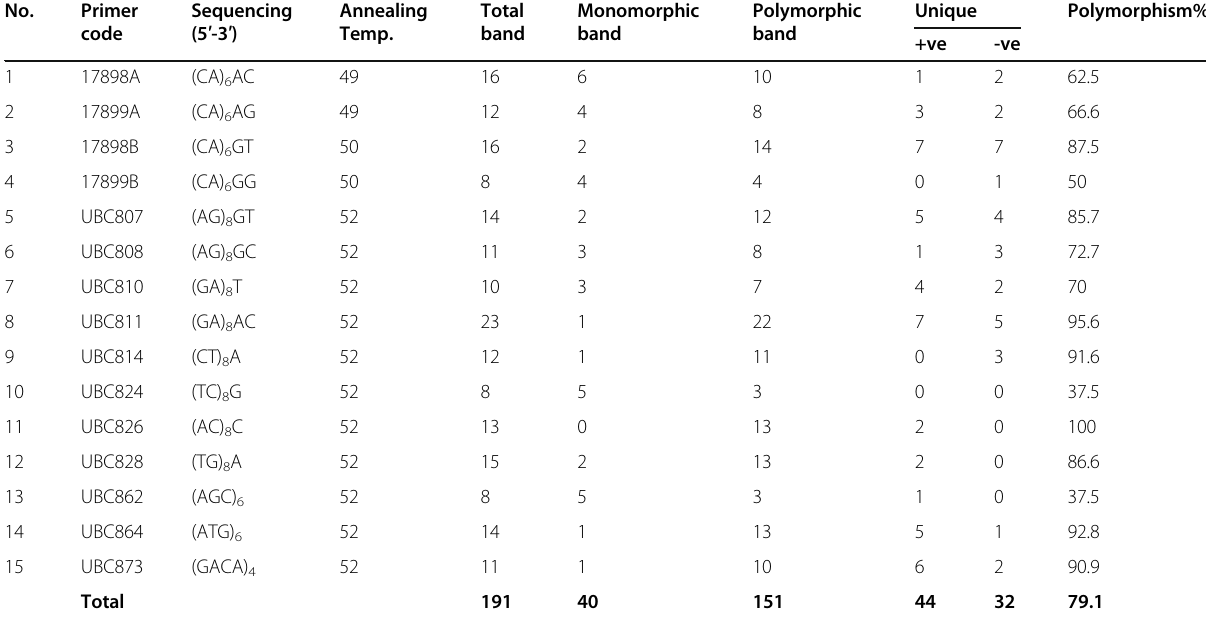
Table 4 List of selected ISSR primers and their codes, sequences, annealing temperature, the number of amplified markers, and percentage of polymorphism for each primer in Salvadora persica samples treated with Fe 3 O 4 , SiO 2 , or ZnO nanoparticles and their controls